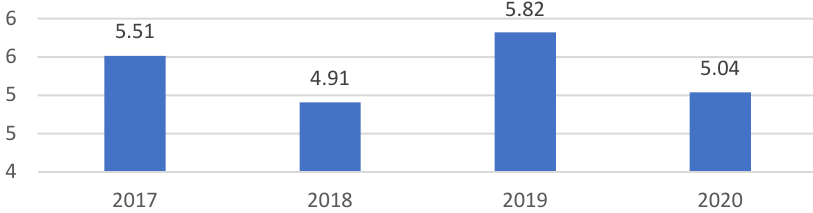
Figure 8. EQM (median) of biogas plants in 2017–2020 (times). Note: our calculations based on the biogas plant’s financial